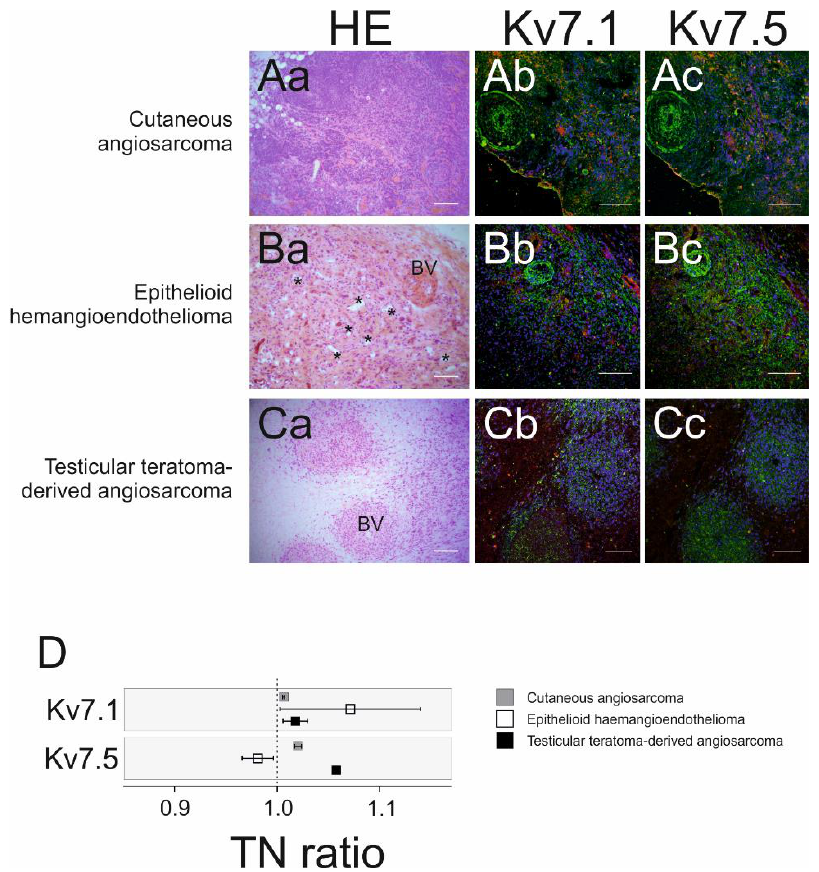
Figure 4. Kv7.1 and Kv7.5 expression in optimal cutting temperature compound (OCT)-embedded malignant vascular tumors. Consecutive sections of vascular tumor samples were stained by hematoxylin-eosin (HE) and immunofluorescent labeling for Kv7.1 and Kv7.5. ( Aa – Ac ) Cutaneous angiosarcoma. ( Ba – Bc ) Epithelioid haemangioendothelioma. ( Ca – Cc ) Testicular teratoma-derived angiosarcoma. ( Aa , Ba , Ca ) HE was used to identify structures. BV: healthy blood vessels; *: tumoral blood vessels. Scale bars 150 μm. Representative immunolabeling images showing merged Kv7.1 ( Ab , Bb , Cb ) and Kv7.5 ( Ac , Bc , Cc ) and tumor biopsies. Red, channels; green, α-actin (muscle); blue, DAPI nuclear staining. Scale bars 150 μm. ( D ) Tumor-to-normal (TN) ratios, in arbitrary units, were calculated from the protein expression levels obtained in immunofluorescence assays and represented in a forest plot. The analysis was performed for Kv7.1 ( top ) and Kv7.5 ( bottom ) channels, plotted in horizontal bars. The reference value (1) is indicated by a dotted line. Squares represent the mean ± SEM of the TN ratio for each patient and tumor. Gray, cutaneous angiosarcoma. White, epithelioid haemangioendothelioma. Black, testicular teratoma-derived angiosarcoma. Mean ± SEM, only represented when multiple samples and regions of interest (ROIs) were available.